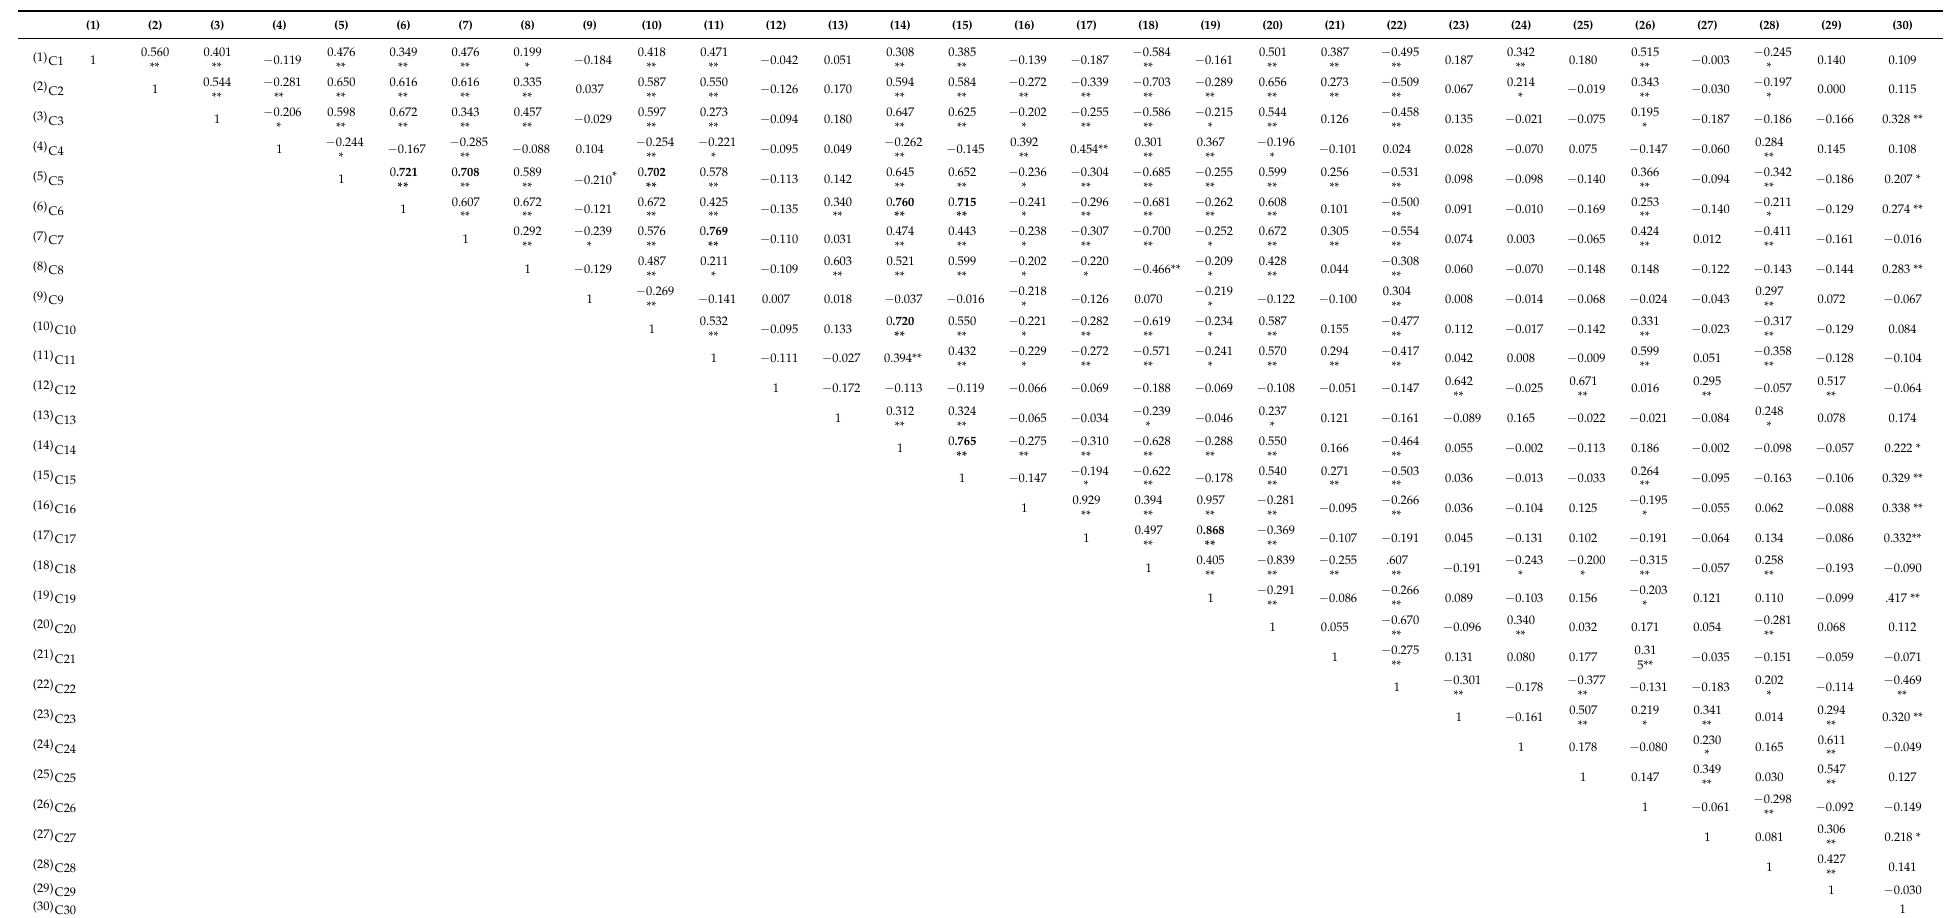
Table 5. Correlation coefficients between 30 essential oil components from T. quinquecostatus